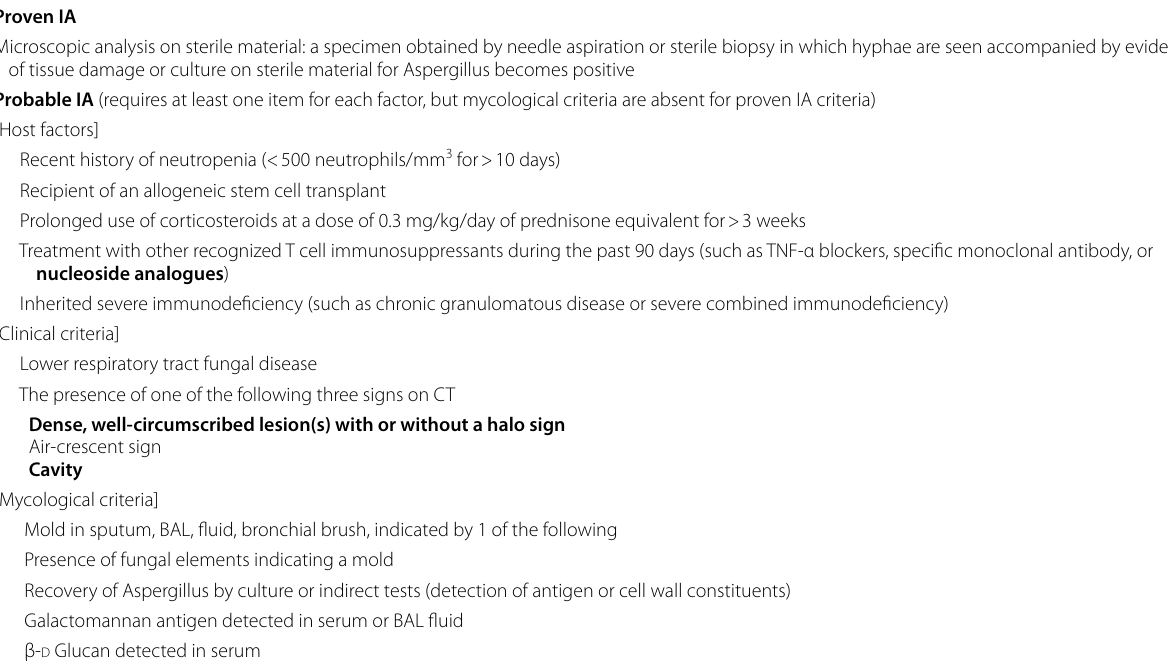
Table 1 Fungal Infectious Cooperative Group and the National Institute of Allergy and Infectious Diseases Mycoses Study Group (EORTC/MSG) criteria for IA [12] (The items which met the current case before LT are described in